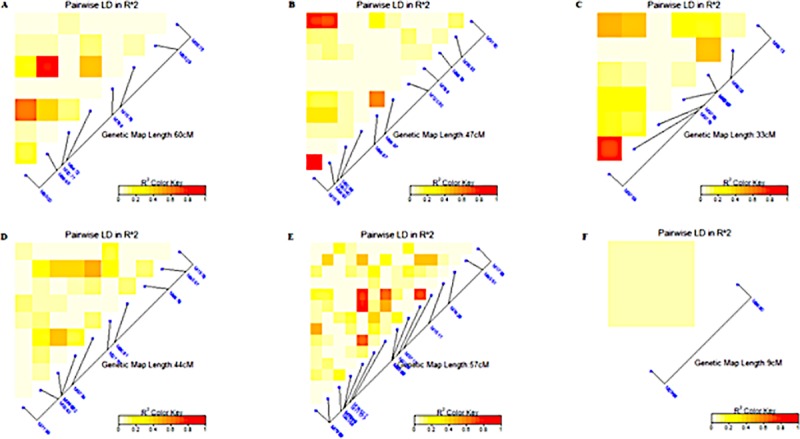
Summary of the local LD among markers with significant MTAs for different traits.A. RB, B. SB and C. GY under non-stress conditions and D. RB, E. SB and F. GY under drought-stress conditions. The R2 color key indicates the degree of significant association.